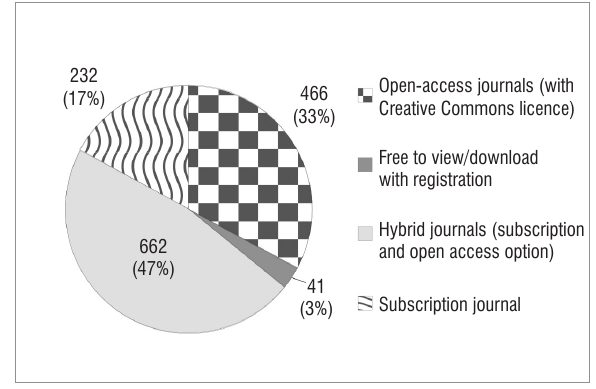
Number of articles published in the top 20 journals in which authors from the University of Cape Town publish (by